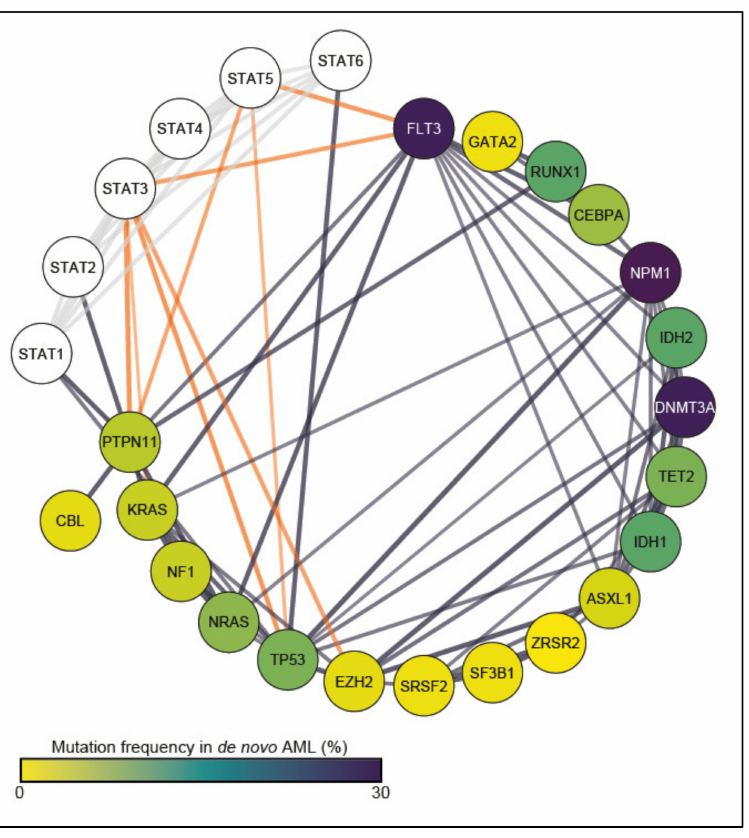
Figure 2. Protein–protein association analysis of STAT proteins and driver mutations in de novo AML. Visualization of STRING protein–protein interaction network of STATs and frequently mutated genes in de novo AML. Analysis includes physical as well as functional interactions of publicly available data [101]. Orange lines show connections of STAT3 or STAT5. The fill color of the nodes represents the mutation frequency of the genes [102]. The line width refers to the STRING interaction score with a confidence cut-off score of 0.7. Connections/protein–protein associations between STATs are illustrated in grey. STAT5A and STAT5B showed the same interactions and were therefore merged to STAT5 for clarity of the